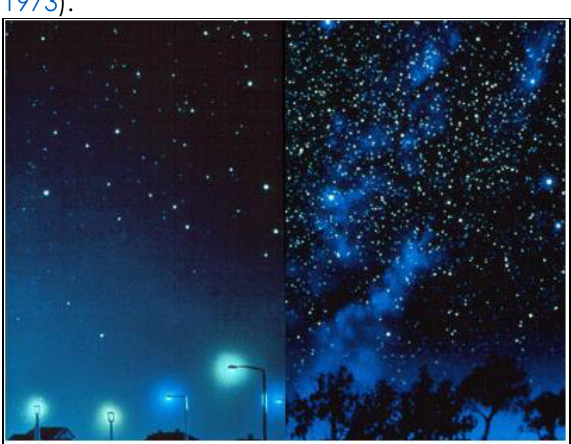
Figure 2. Before and during the 2003 Northeast blackout, a massive power outage that affected 55 million people. Photo by of Todd Carlson (http://www.darksky.org/light-